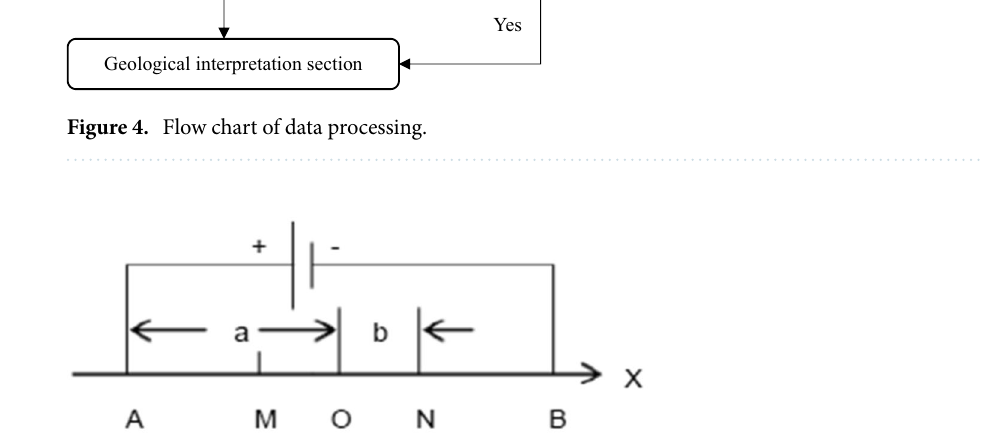
Figure 5. Schematic diagram of quadrupole vertical electrical sounding